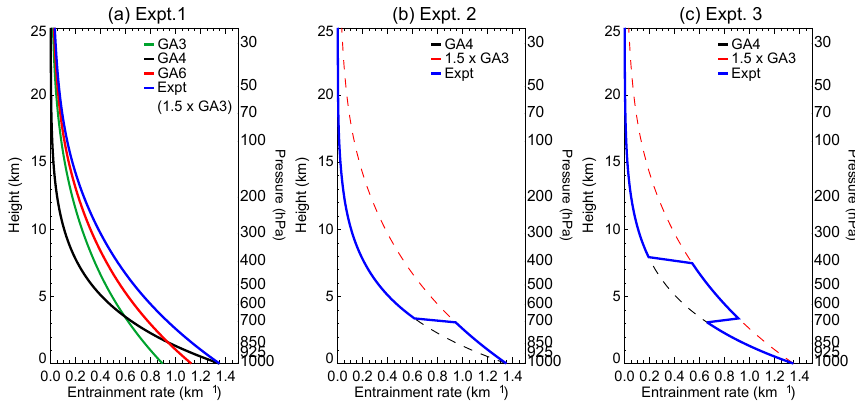
Figure 3. Examples of the idealised entrainment profiles for the experiments. Panel (a) shows the profiles of deep and mid-level entrainment in GA4 and the test profile (expt) with [ α in the second experiment. For third experiment [ α of the levels follow a [ α